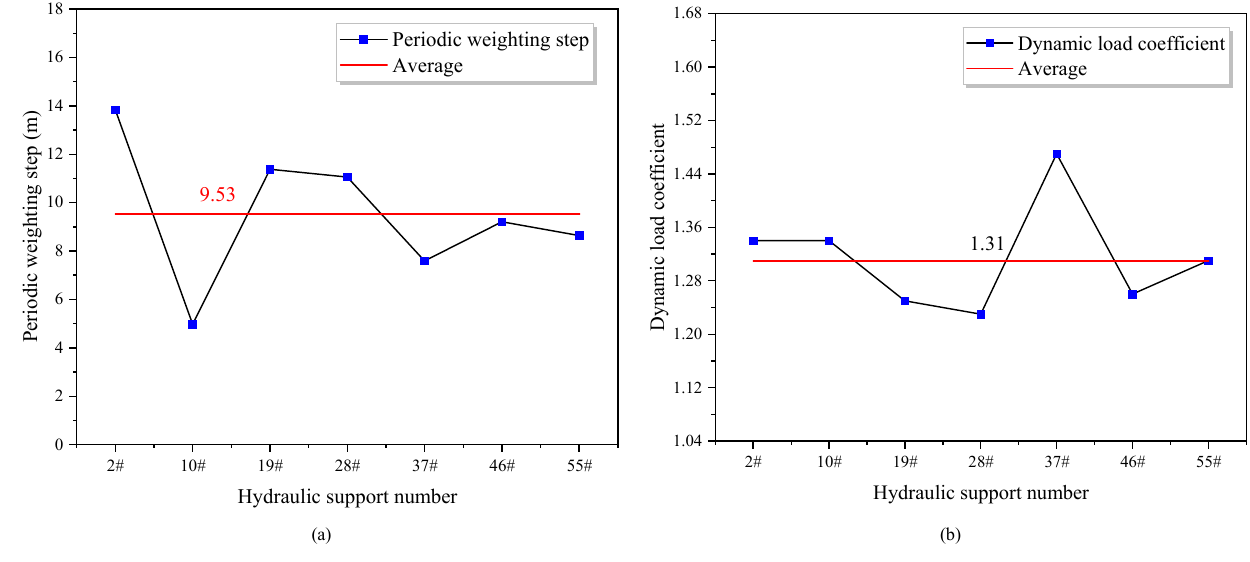
Figure 9. Characteristics of periodic weighting after hydraulic fracturing: ( a ) periodic weighting step; ( b ) dynamic load coefficient.